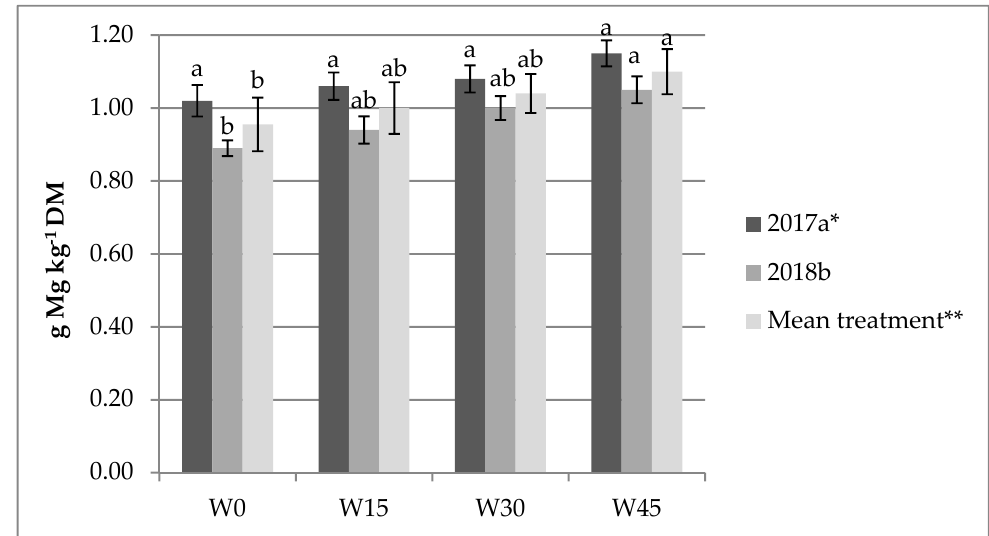
Figure 5. Magnesium content in maize grain. W0—the control with no stillage treatment, W15—15 m 3 of stillage per hectare, W30—30 m 3 of stillage per hectare, W45—45 m 3 of stillage per hectare. * means of years regardless of treatments; ** means of treatments regardless of years. The same letter means not significantly di ff erent. Agronomy 2019 , 9 , x FOR PEER REVIEW